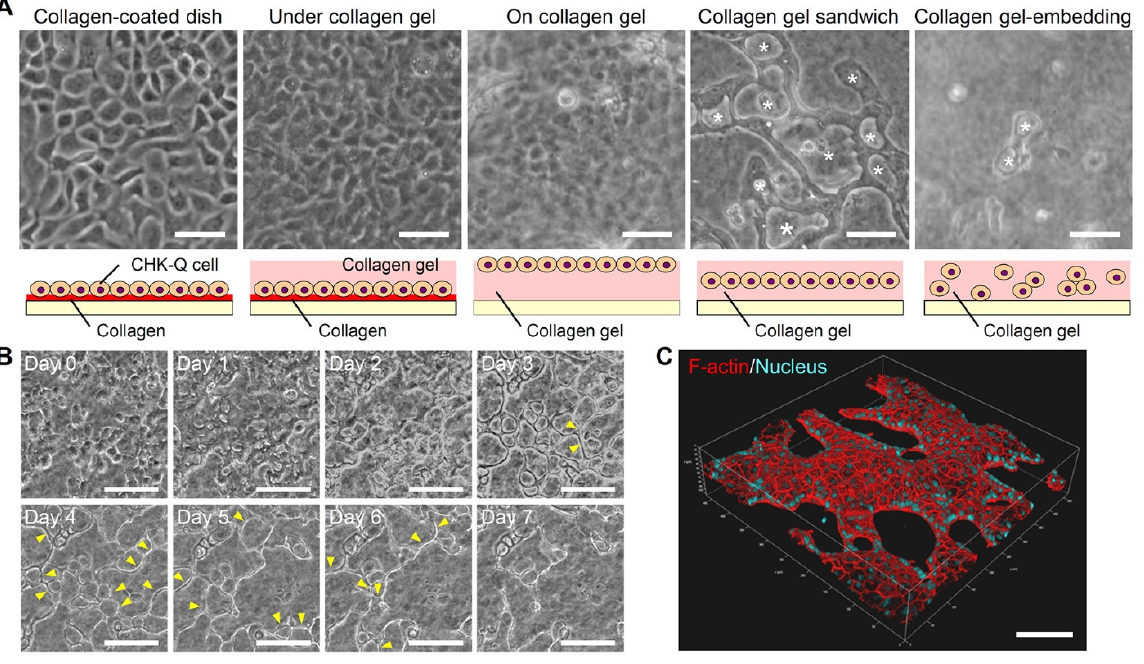
Figure 1. CHK-Q cell morphologies. ( A ) Phase-contrast micrographs at 1.0 × 10 5 cells/cm 2 after 3 culture days. Asterisk: cyst tissues. ( B ) Time-lapse observation and ( C ) 3D image of a cyst with collagen gel sandwich at 1.7 × 10 5 cells/cm 2 . Yellow arrowhead: reconstructed cyst wall. Red (rhodamine phalloidin): F-actin, Blue (Hoechst 33342): Nuclei. Bars represent 100 µ